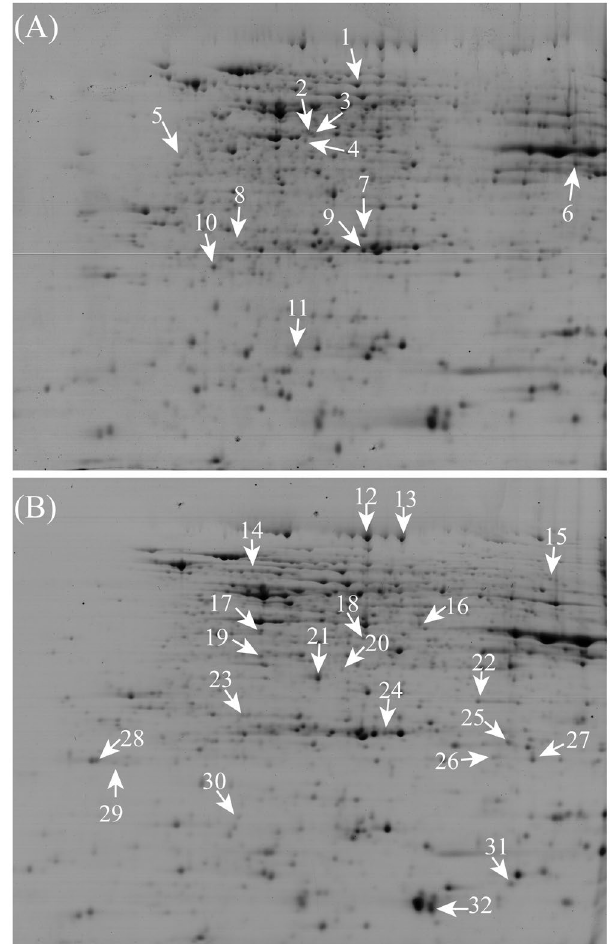
Figure 2. Typical 2-DE gels of total proteins from maize seeds. A total of 32 identified DEPs between PT and NT maize seeds were indicated with arrows in the gel images. The 11 DEPs with increased abundance ( A ) and 21 down-regulated DEPs ( B ) in PT maize seeds were highlighted in the 2-DE gels. The full-length original 2-DE gels were also presented in Supplementary Figure